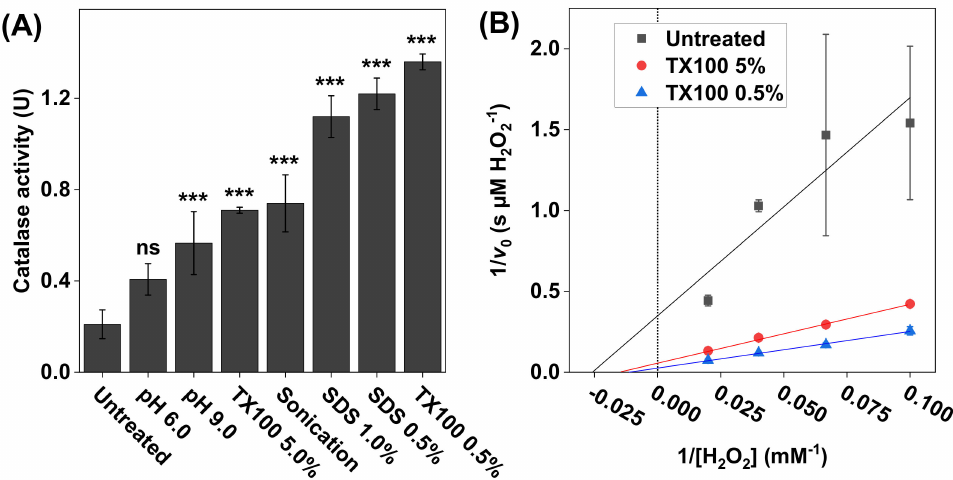
Figure 3. ( A ) The effect of treatment protocol on the catalase activity measured with 2 × 10 5 HaCaT keratinocytes dispersed in PBS. The treatments included adjusted pH values (6.0 and 9.0), 60s cell incubation in Triton X100 (0.5 wt% or 5.0 wt%) or in SDS (0.5 wt% or 1 wt%), or sonication. All experiments were performed in triplicates ( n = 3, mean ± SD) with 10 mM H 2 O 2 and pH 7.5 (if